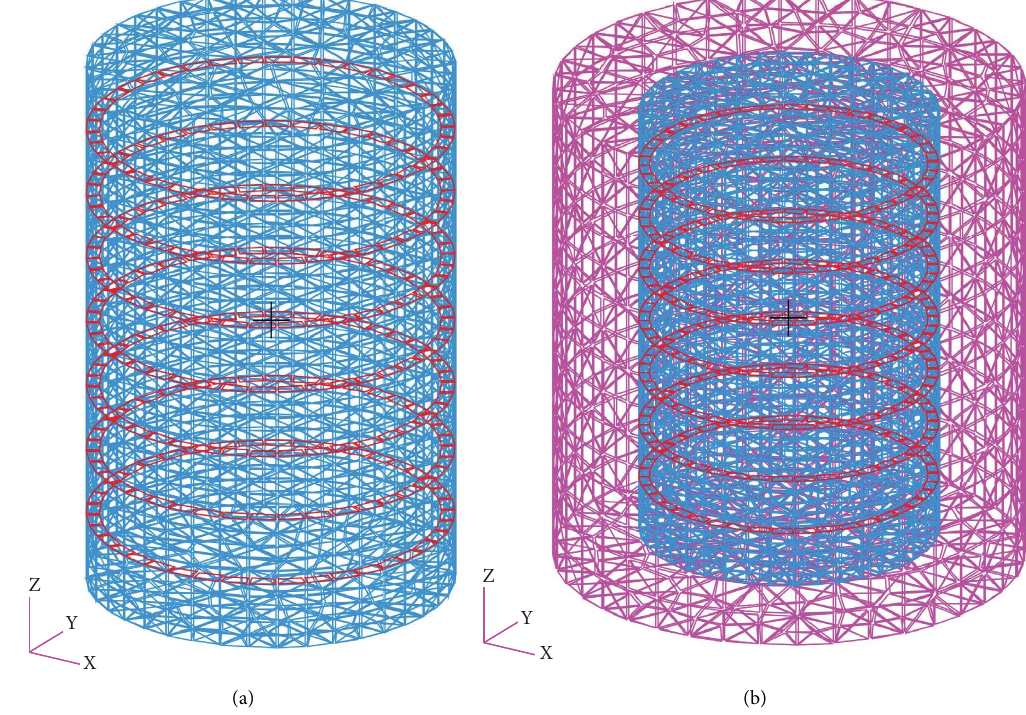
Figure 7: (a) FE elements of FEM-BEM; (b) FE elements of FE-FE-BE method.